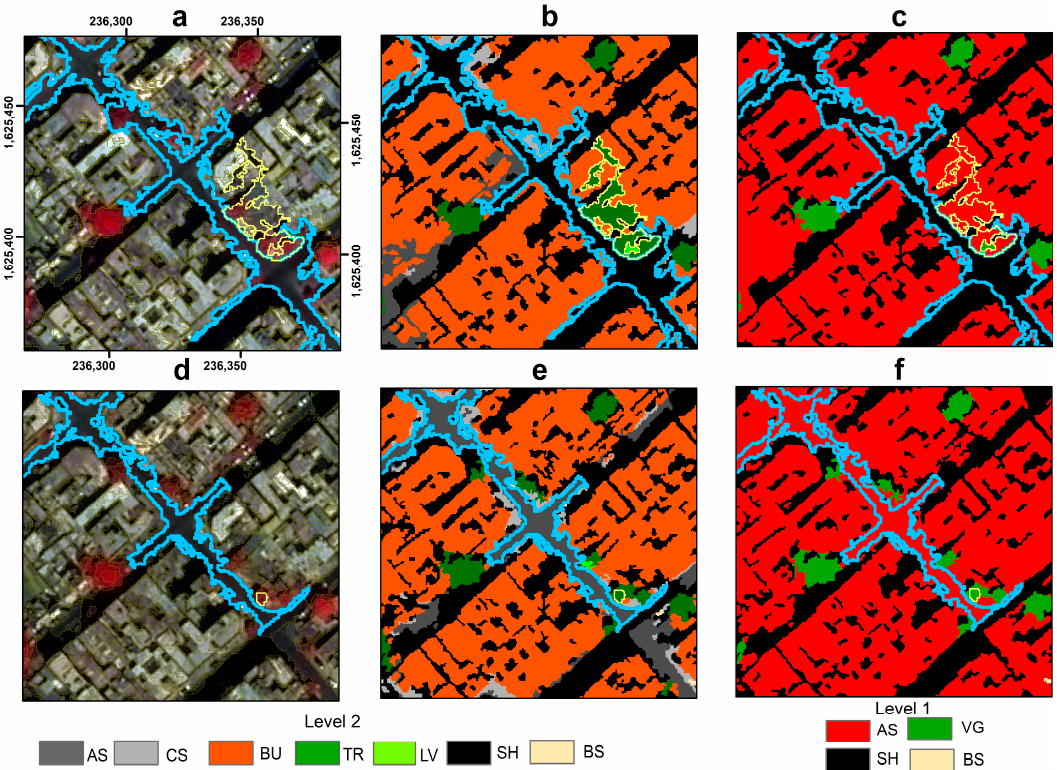
Figure 10. Classification results for the two approaches at two levels from ROI 1. ( a ) Segmentation and highlighted objects from the FT method, ( b ) classification results for Classification Level 2 and ( c ) Classification Level 1 for FT, ( d ) Segmentation and highlighted objects from the LOESS method, ( e ) classification results for Classification Level 2 and ( f ) Classification level 1 for LOESS.